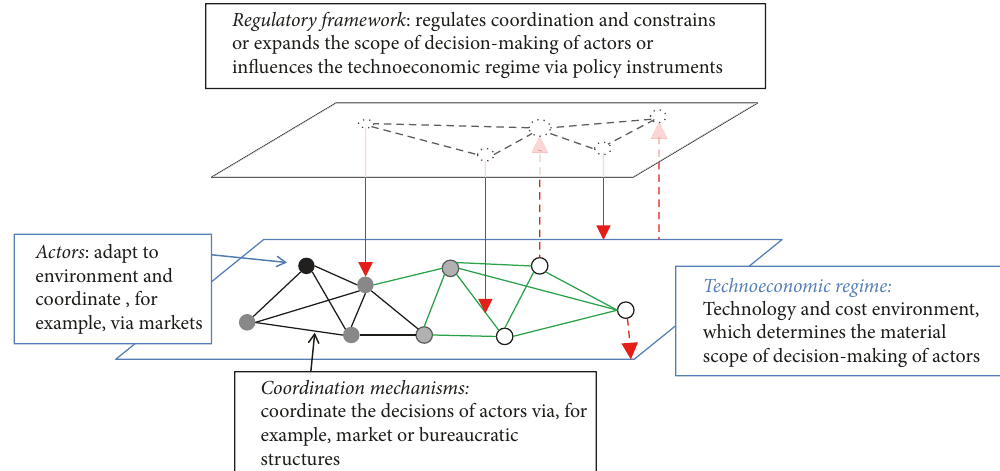
Figure 1: A sketch of the system that is represented by the AMIRIS